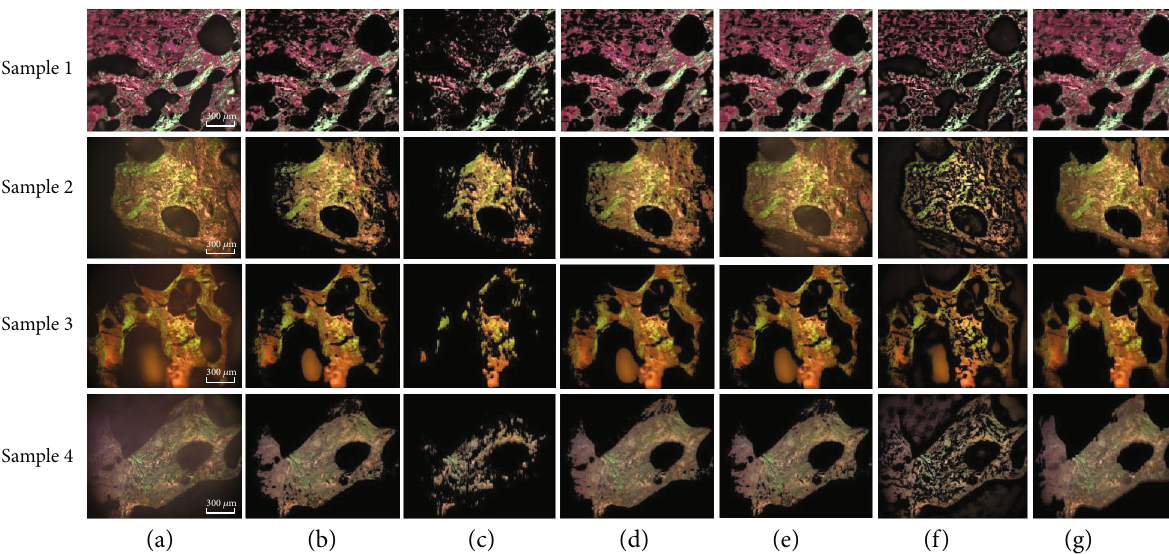
Figure 14: Di ff erent methods to extract the pixels of the main body: (a) original image; (b) Otsu algorithm; (c) morphological fi ltering; (d) watershed algorithm; (e) fi x threshold; (f) adaptive threshold; (g)